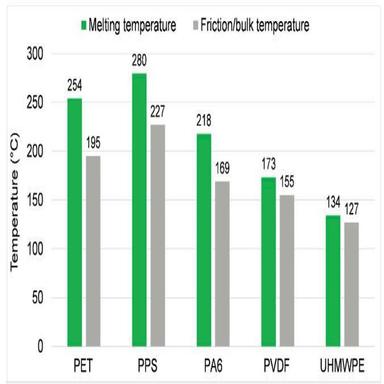
Melting temperature and friction/bulk temperature of tested semicrystalline samples.